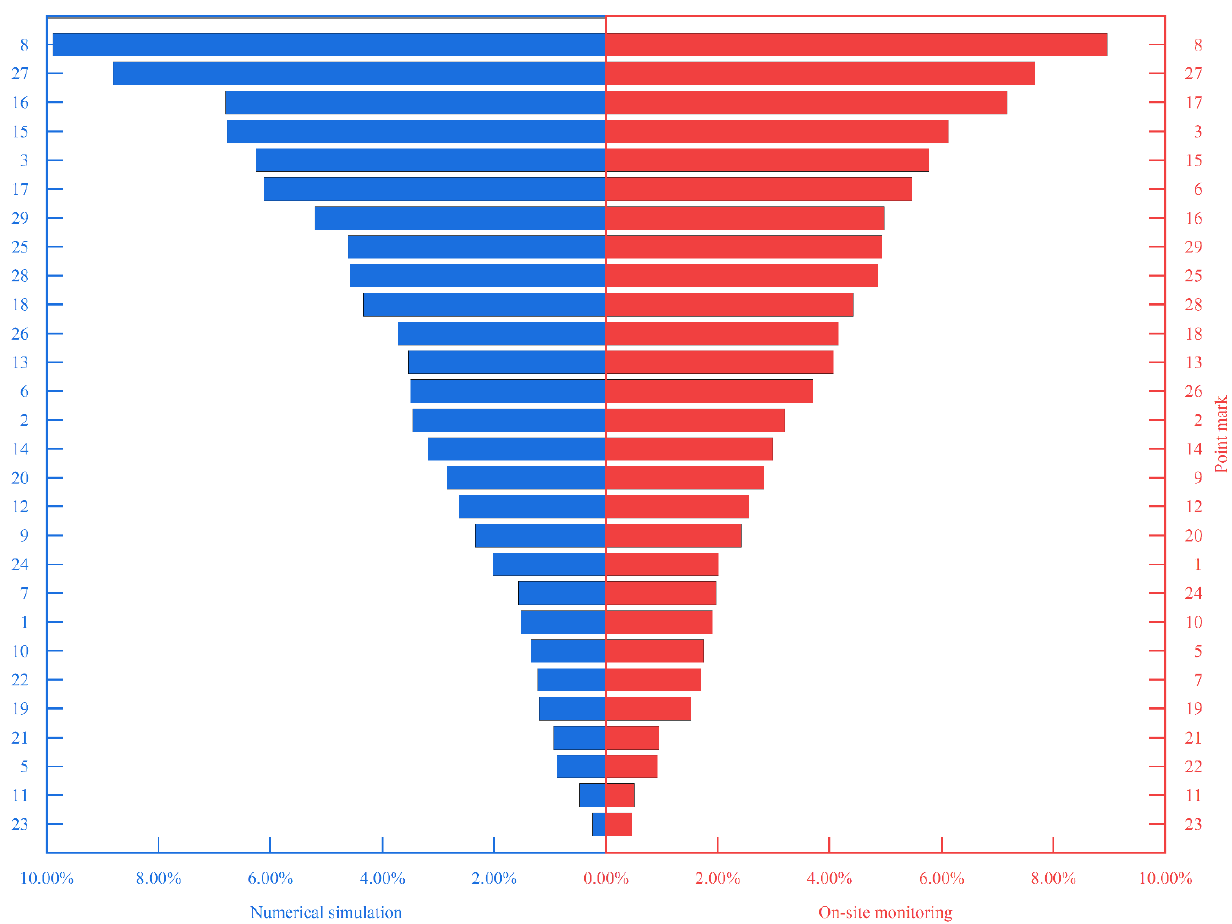
Figure 11. Contribution series of monitoring data and numerical simulation data on mechanical properties of E030 based on time domain.